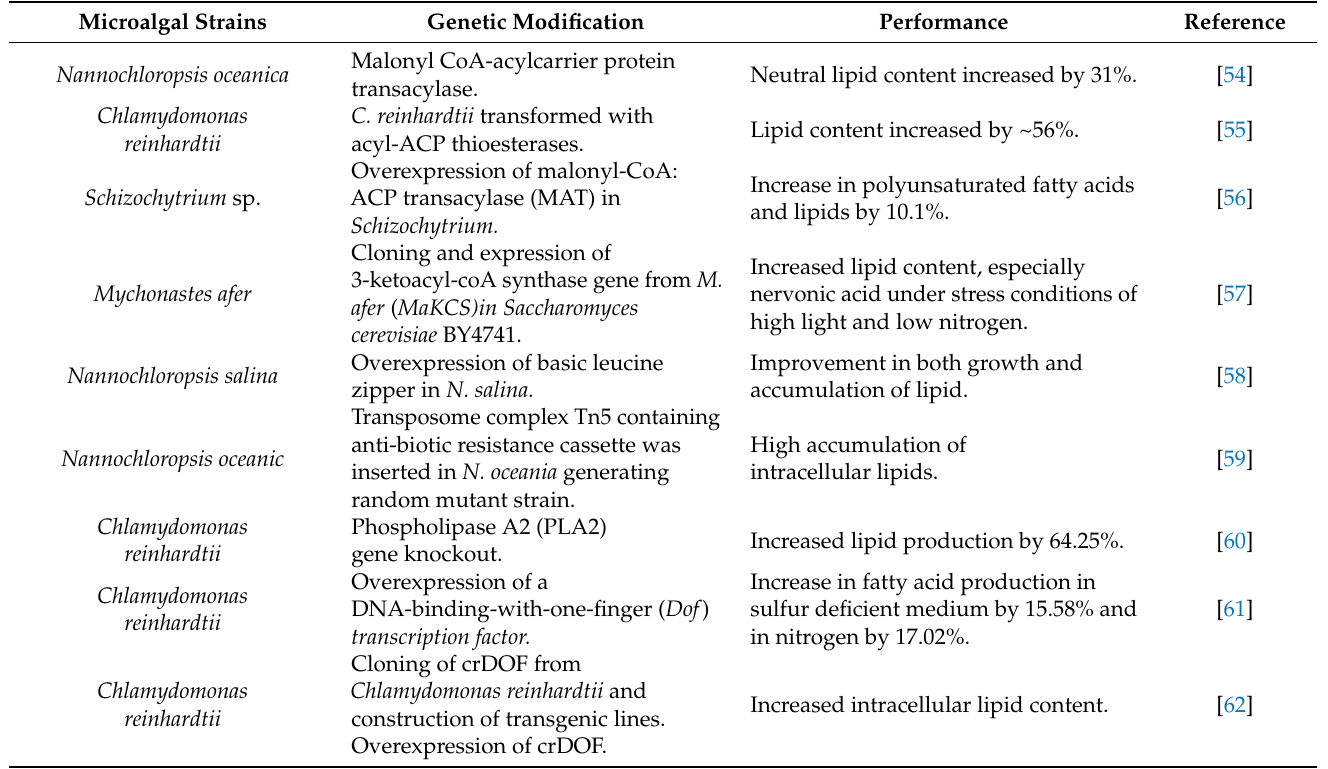
Table 4. Previously reported genetic and metabolic engineering modification of microalgae for the enhancement of lipid